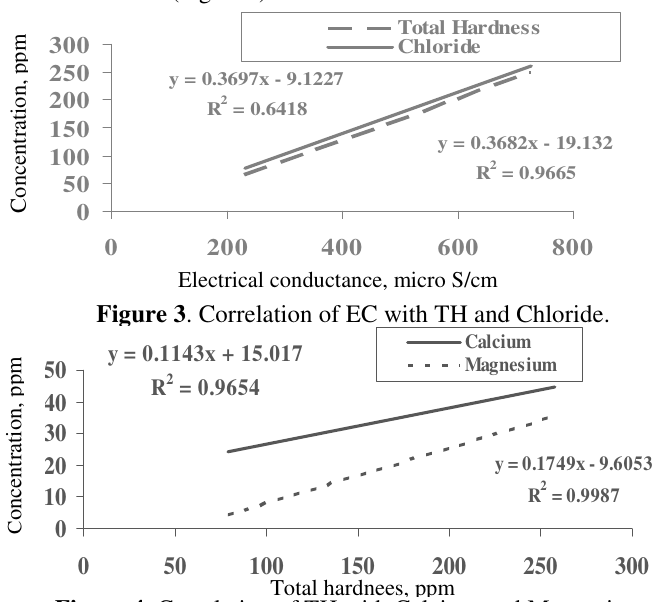
Figure 4. Correlation of TH with Calcium and